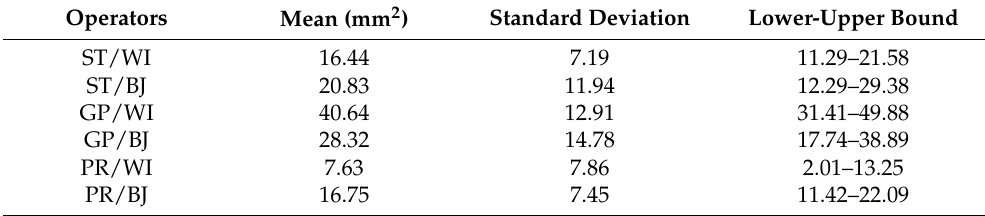
Table 2. Results in mm 2 of exposed dentin areas: mean, standard deviation, and lower-upper bound (95% confidence interval).